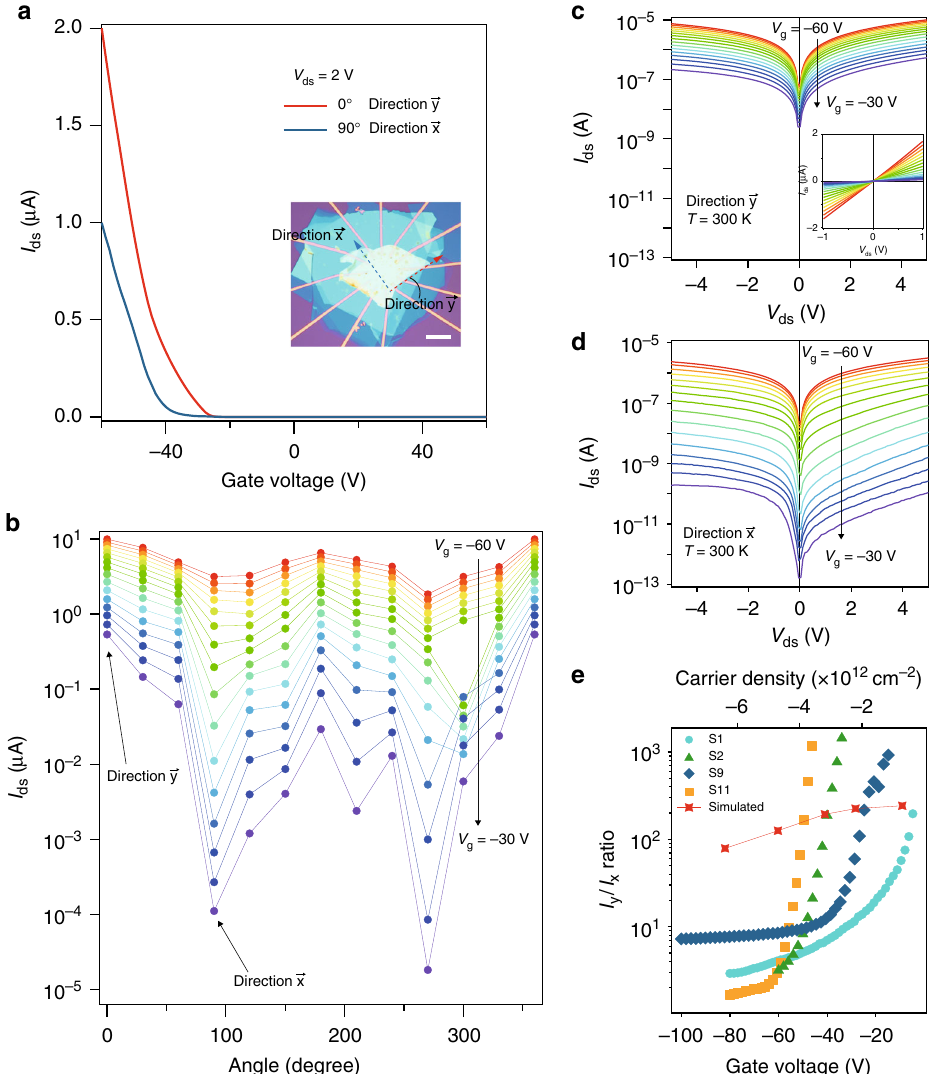
Fig. 2 Giant anisotropic resistance in ultra-thin GaTe. a Field effect curves of a typical GaTe device (Sample S2) recorded along x and y directions, with the optical image of the device shown in the inset. Scale bar in the inset is 10 μ m. b I ds of the same device measured along the 12 directions with a fi xed V ds = 5 V, and with the gate voltages swept from − 60 V to − 30 V. c , d I – V curves plotted in log scale at V ds = ±5 V of the same device measured along y and x directions, respectively. The gate voltages were swept from − 60 V to − 30 V. Inset of c shows the corresponding data in linear scale. e The maximal electrical anisotropic ratio I y / I x extracted from different samples (denoted as S1, S2, S9, and S11) as a function of gate